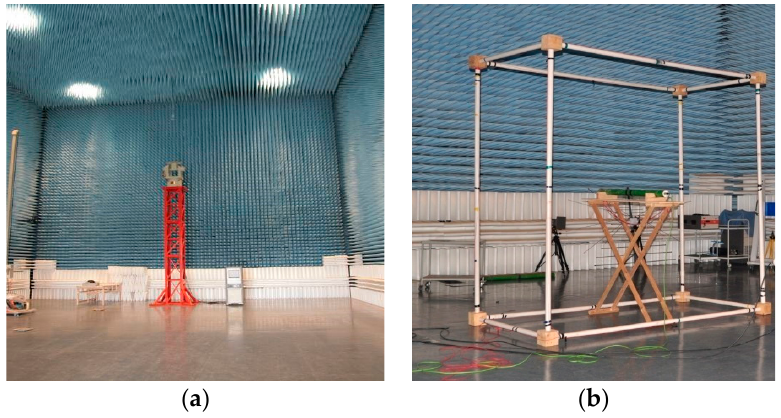
Figure 6. Schematic diagram of a calibration environment and the calibration equipment ( a ) Mag- netic shielding room; ( b ) Schematic diagram of calibration coil in an actual environment. (The photos the BD-6 instrument is tested).